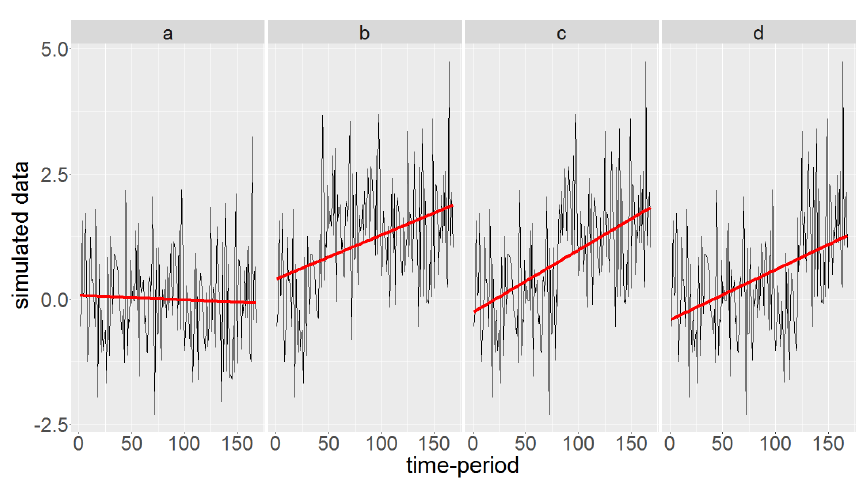
Figure 3. Normally distributed, time-ordered data and the fitted regression line in red. Panel a shows the original data. In panels b, c, and d an artificial abrupt change of magnitude 1.5 is initiated at the 40th, 80th, and 120th time-periods respectively.